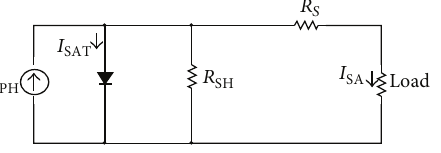
Figure 2: Equivalent circuit of a solar cell. Table 2: Factor of 𝐴 depends on PV technology [31].